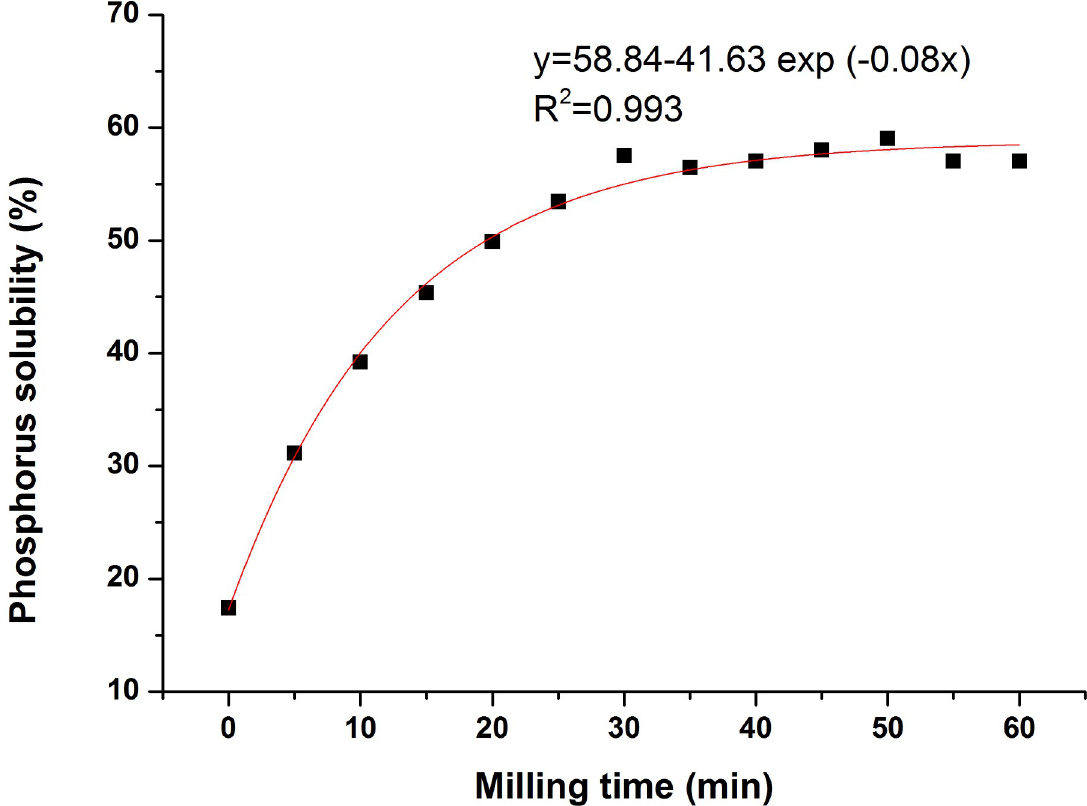
Fig 1. Significant dependence of the solubility of phosphorus originating from phosphorite in citric acid on the milling time from 0 to 60 min.